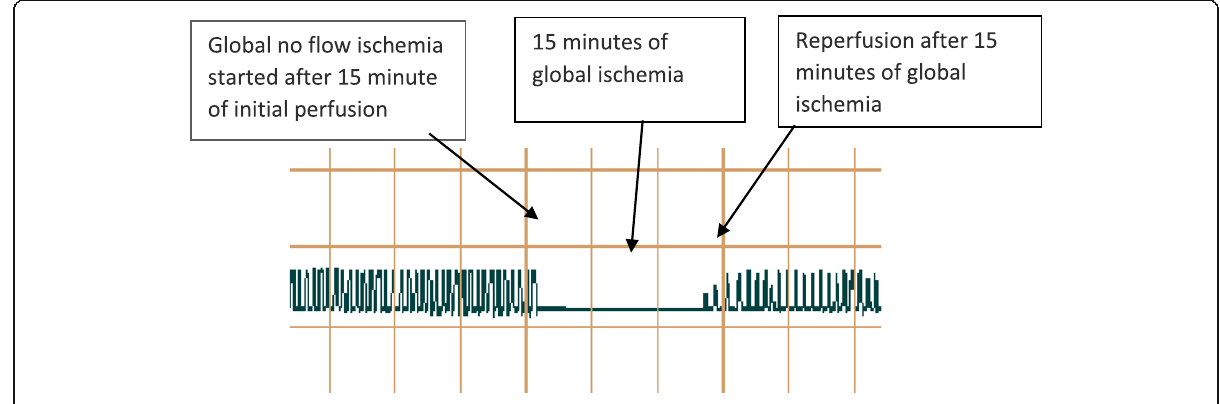
Fig. 8 Tracing on Polygraph of STV-100